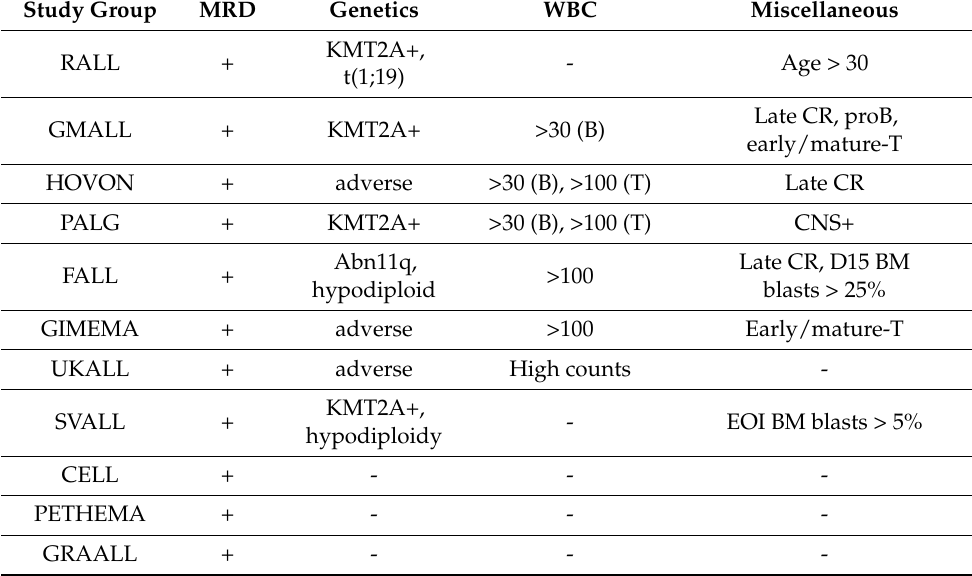
Table 3. Summary of risk factors considered by 11 European adult ALL study groups for risk stratification orientating the choice of an allogeneic HCT in first CHR in Ph − ALL (all studies including AYA patients), adapted from [54]. For MRD levels defining MRD POS